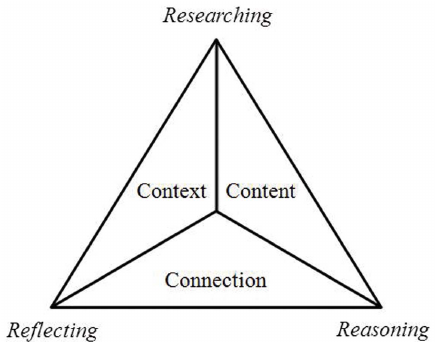
Figure 1. Framework of a 3C3R-PBL problem design.